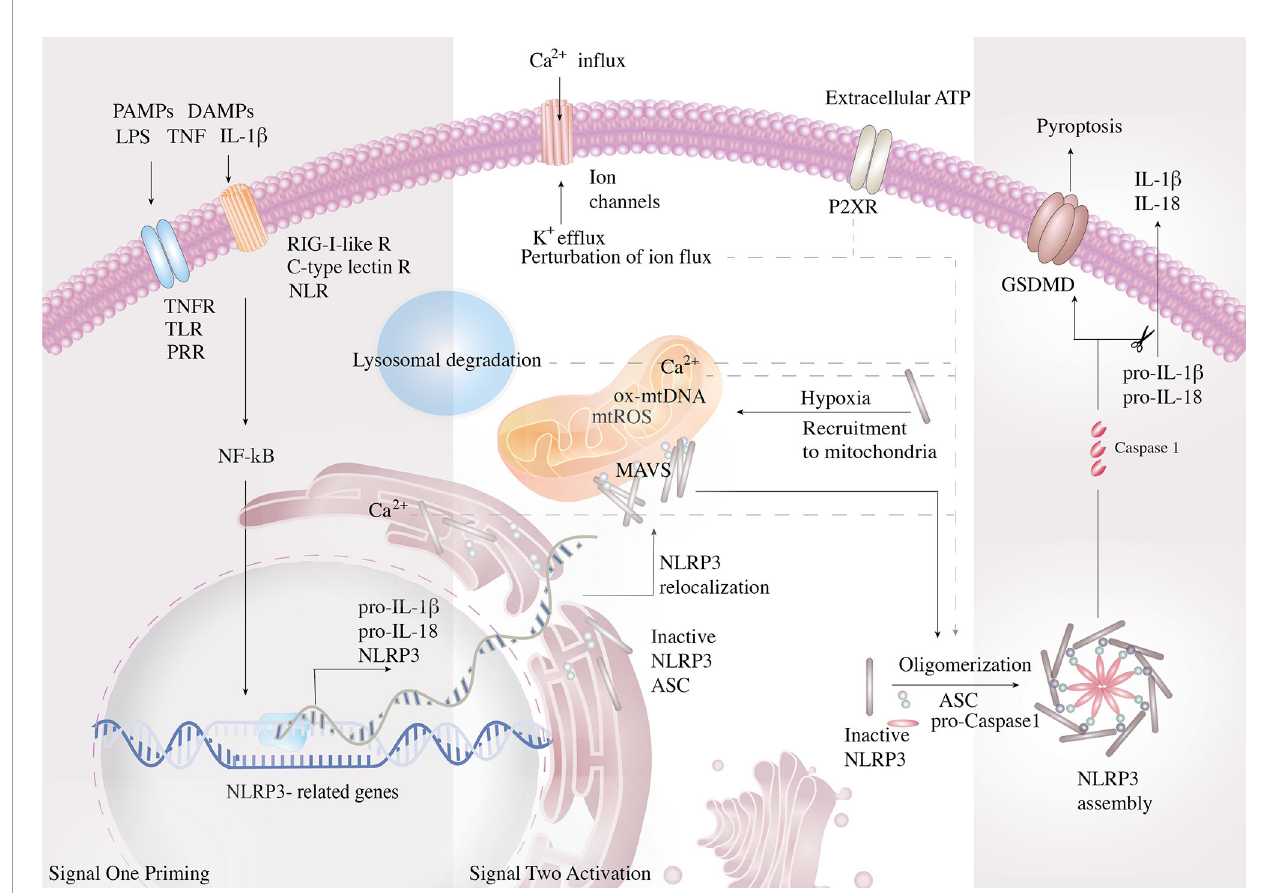
FIGURE 1 | Mechanism and regulation of NLRP3 in fl ammasome activation. NLRP3 in fl ammasome is activated in a two-step process. First, NF- k B is initially activated by the pathogen-associated molecular patterns (PAMPs)- and damage-associated molecular pattern (DAMP)-mediated signal cascades and induces the transcription of NLRP3 in fl ammasome components and the inactive un-spliced cytokines. PAMPs are recognized by pattern-recognition receptors (PRRs, including Toll-like receptors, NLRs, RIG-I-like receptors, C-type lectin receptors). Signal two assembles the in fl ammasome complex via oligomerization and activates caspase- 1, the pore-forming protein gasdermin D (GSDMD), and the in fl ammatory cytokines. Signal two arises from lysosomal activity. Signal two activating DAMPs consist of perturbation of ion fl ux, extracellular adenosine triphosphate (ATP), lysosomal degradation, mitochondrial reactive oxygen species (mtROS), and oxidized mitochondrial DNA (ox-mtDNA). To improve ef fi ciency of oligomerization, the organelles work in conjunction to strategically bring the components close to the vital organelles and then together. Resting NLRP3 localizes to endoplasmic reticulum, whereas it is redistributed to mitochondria via mitochondria-associated adaptor molecule (MAV) when